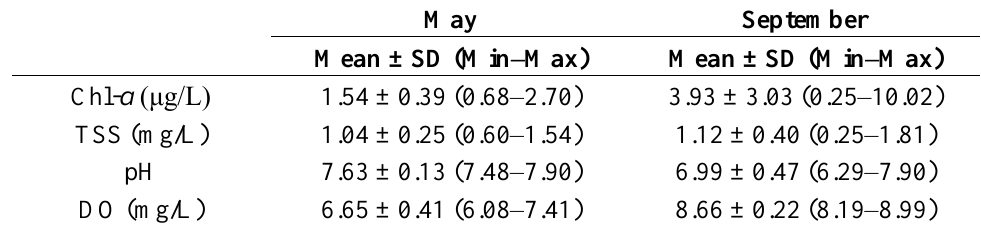
Table 2. Summary statistics for chlorophyll- a (chl- a ), total suspended solids (TSS), pH and dissolved oxygen (DO) for water samples collected in the Itumbiara Reservoir in 2009 during the May and September field campaigns.